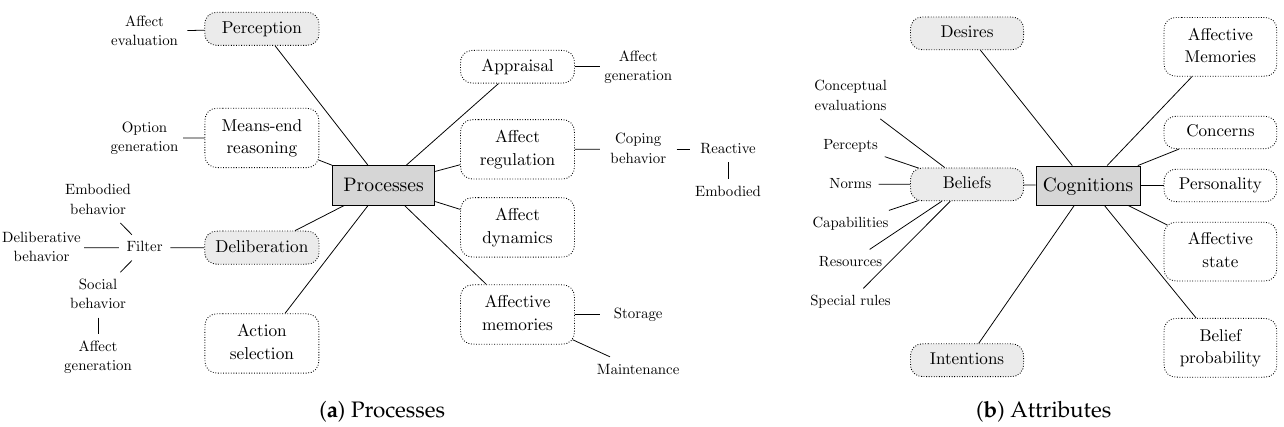
Figure 1. Proposal of conceptual systems for a BDI affective agent. ( a ) The main processes of a BDI affective agent; ( b ) The components of a BDI affective agent related to the processes of practical reasoning ( perception and deliberation